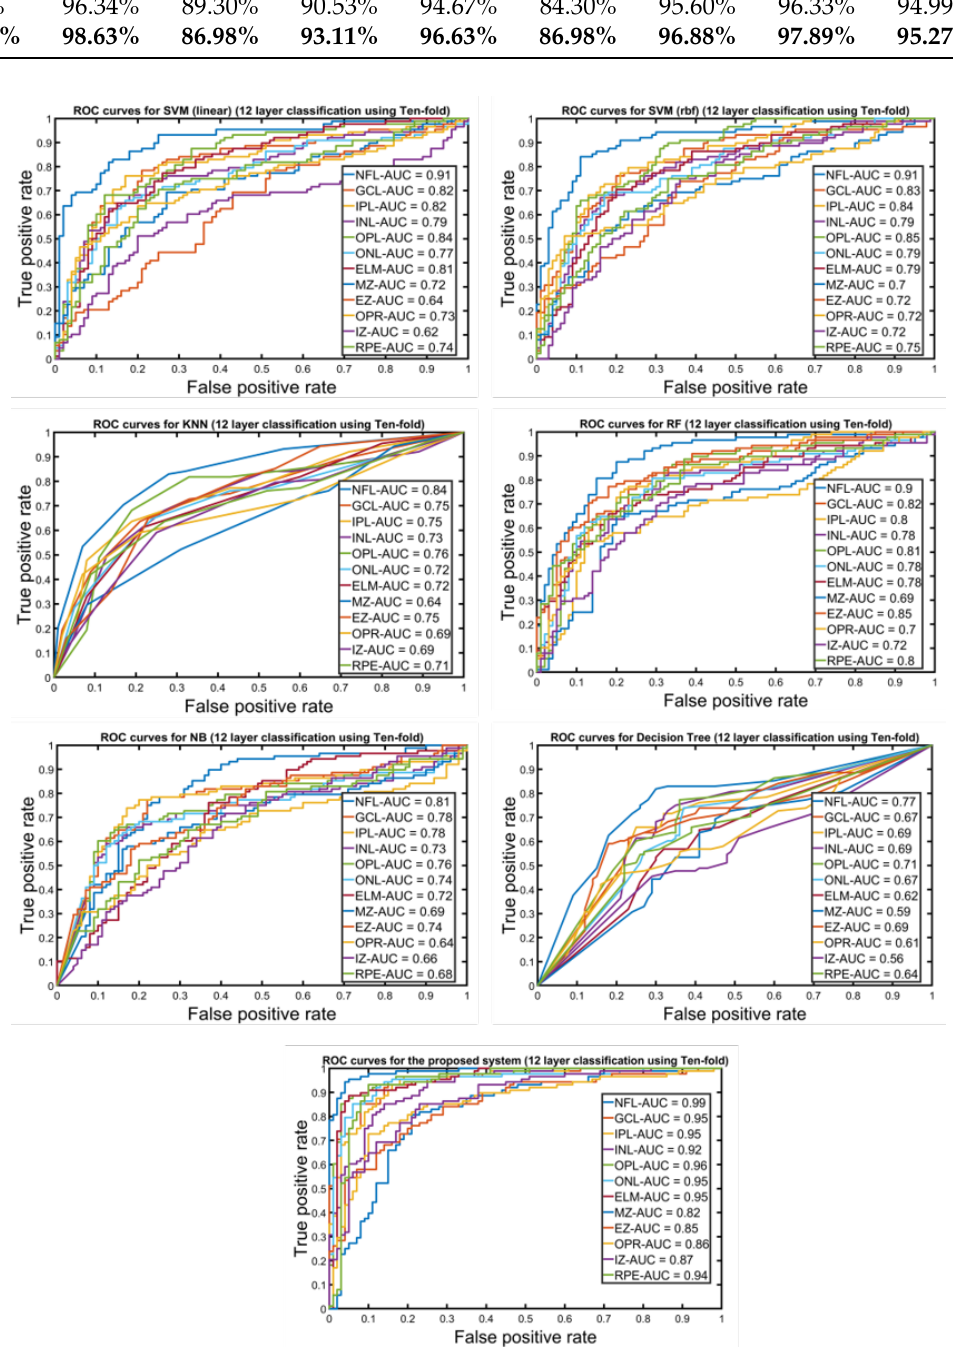
Figure 6. An illustrative ROC curves for the classification of 12 layers for the proposed system in comparison with other machine learning approaches using ten-fold